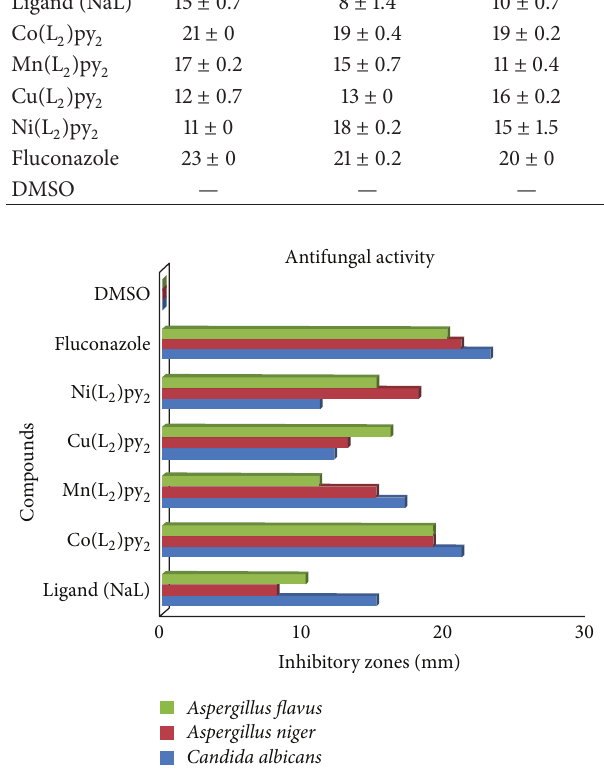
Figure 2: A histogram representative of antifungal activities of the pyridine